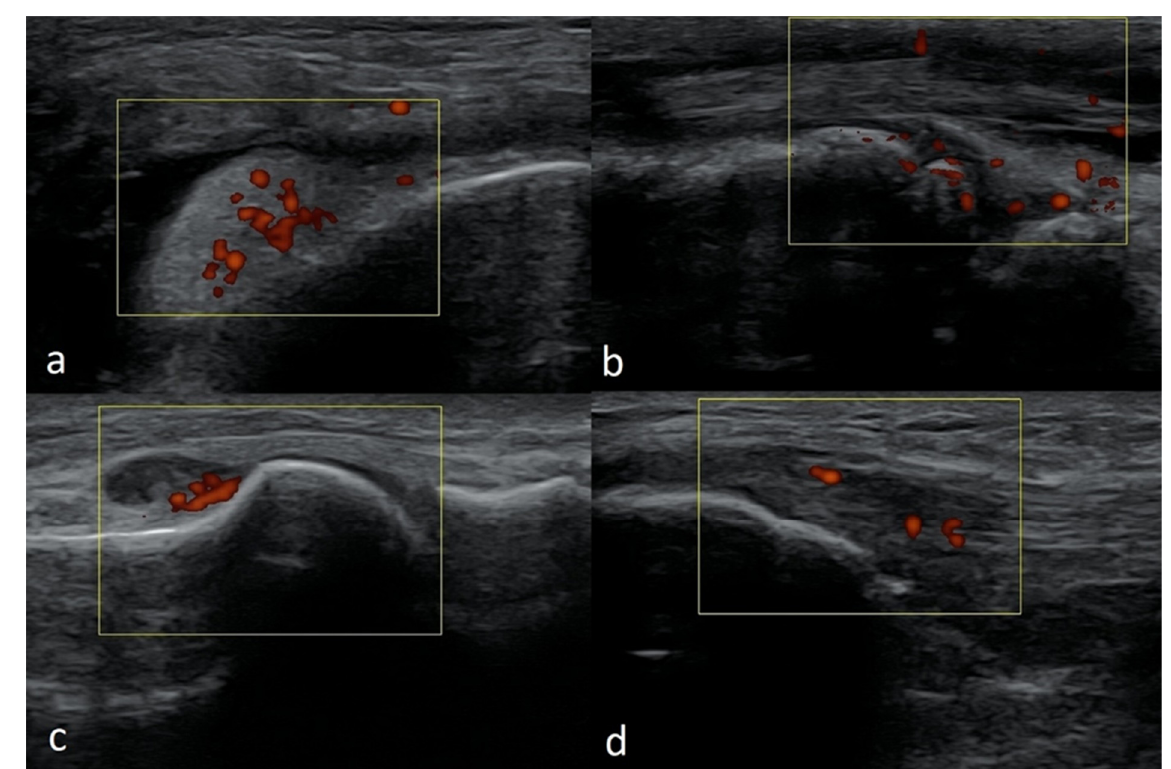
Figure 17. ( a ) Transverse scan through the lateral part of the suprapatellar recess in a 9-year-old girl with synovitis of the knee joint, showing visible synovial hypertrophy with increased vascularization. ( b ) Tenosynovitis of tibialis posterior at the level of the medial malleolus, with visible synovial thickening, hypervascularity, and increased amount of fluid around the tendon. ( c ) Synovitis of the I metatarsophalangeal joint in a 47-year-old female, showing increased amounts of fluid and a thickened, hypervascularised synovium. ( d ) Enthesitis of patellar tendon in a 37-year-old male, showing thickening, decreased echogenicity, and features of increased vascularization. Linear probe 3–12 MHz.